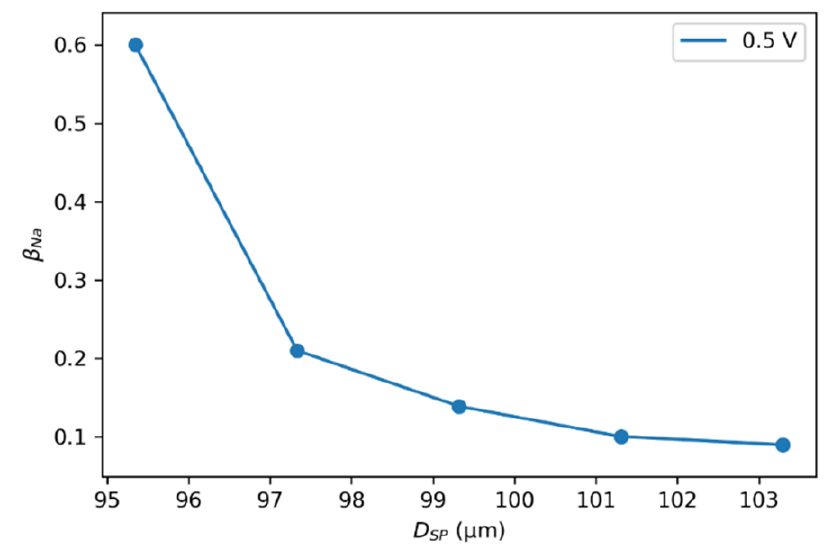
Figure 10. 𝛽 (cid:3015)(cid:3028) as a function of SP size with 𝐷 (cid:3010)(cid:3002) = 𝐷 (cid:3020)(cid:3017) . Calculations were performed using the ex- perimental reference data of EFC charging at a constant voltage of 0.5 V. Figure 10. β Na as a function of SP size with D IA = D SP . Calculations were performed using the = 𝐷 Figure 10. 𝛽 as a function of SP size with 𝐷 . Calculations were performed using the ex- (cid:3015)(cid:3028) (cid:3010)(cid:3002) (cid:3020)(cid:3017) experimental reference data of EFC charging at a constant voltage of 0.5 V. perimental reference data of EFC charging at a constant voltage of 0.5 V.